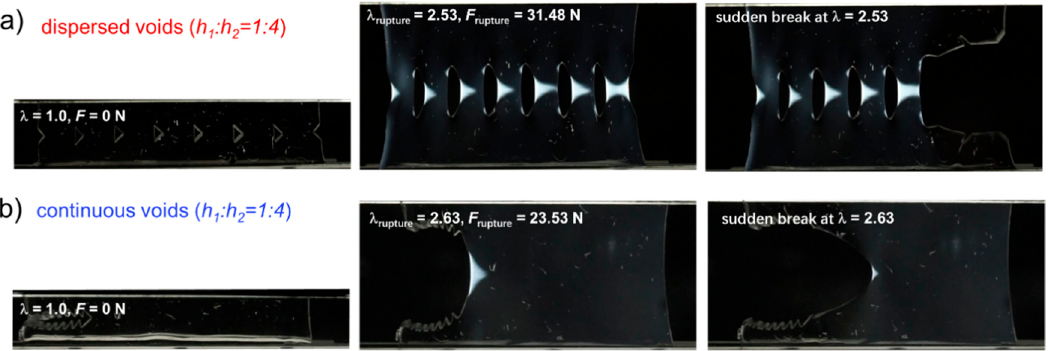
Figure 7. Birefringence observation during fracture of D-cut and C-cut gels at spacing ratio h 1 : h 2 of 1:4. ( a , b ) The representative snapshots of crack evolution in DN hydrogel samples under different structural models containing dispersed cuts ( a , D-cut gel) and continuous cuts ( b , C-cut gel) at spac- ing ratio h 1 : h 2 of 1:4.